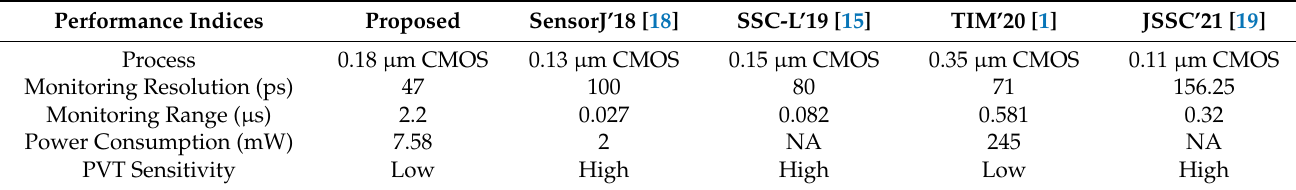
Table 2. Performance